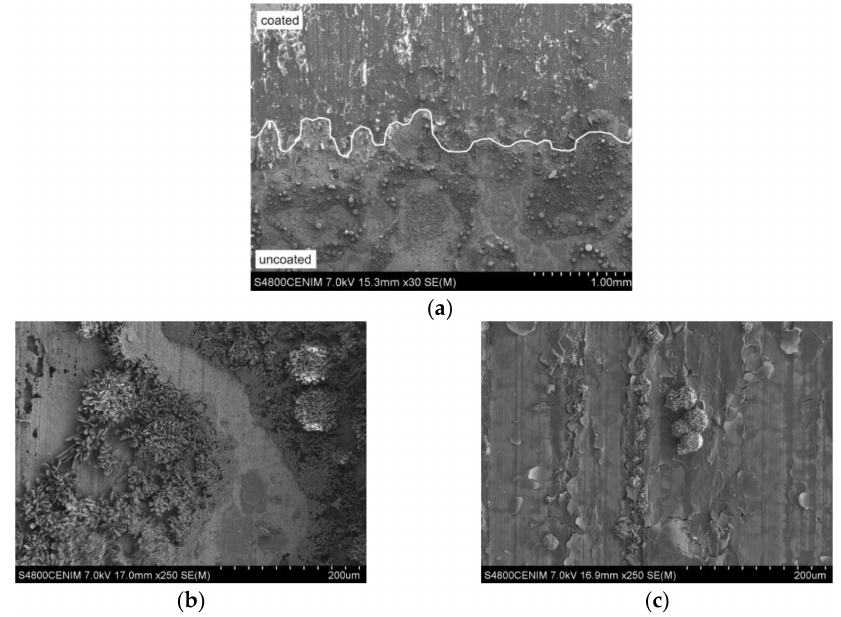
Figure 7. ( a ) FESEM image of a copper substrate in the coated/uncoated interface (La(NO 3 ) 3 doped coating) after the weathering test in the Kesternich Chamber; ( b ) Detail of the uncoated area; ( c ) Detail of the coated